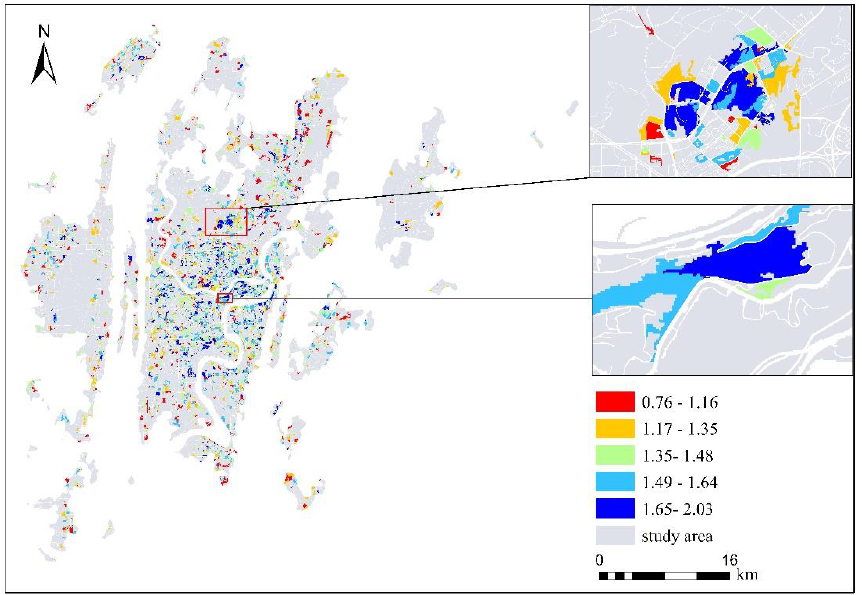
Figure 6. Distribution diagram of the functional mixing